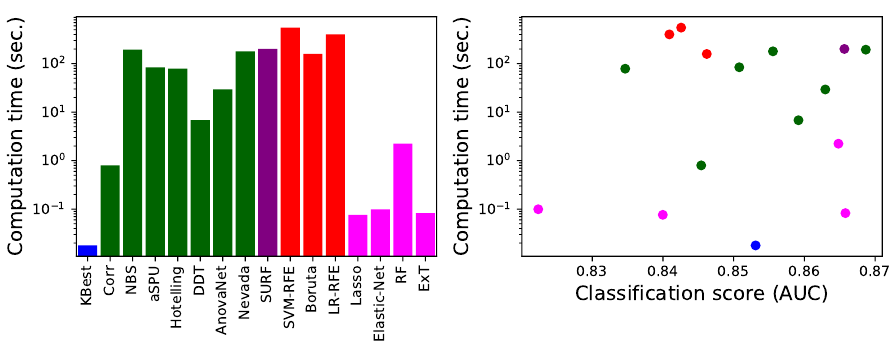
Figure 8. Computational cost analysis. ( Left ) Computation time for each link selection method (excluding the three underperforming ones), measured in seconds. ( Right ) Scatter plot of the compu- tation time as a function of the performance (in terms of AUC) of each method. Colour code as per Figure